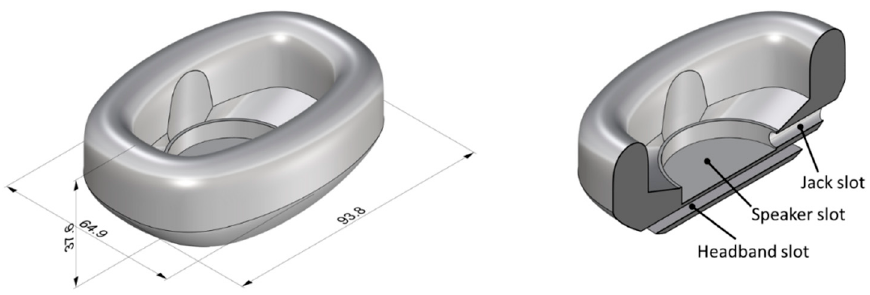
Figure 3. Surface model: main dimensions and internal detail.